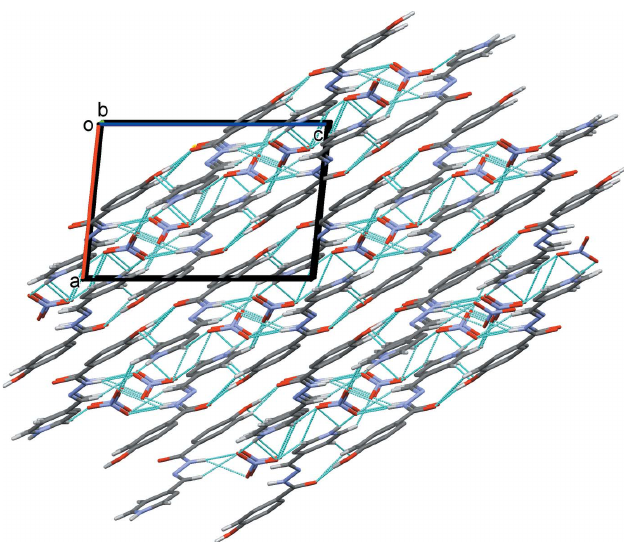
Figure 3 A view along the b axis of the crystal packing of the title compound. The hydrogen bonds are shown as dashed lines (see Table 1), and only H atoms involved in these interactions have been included.